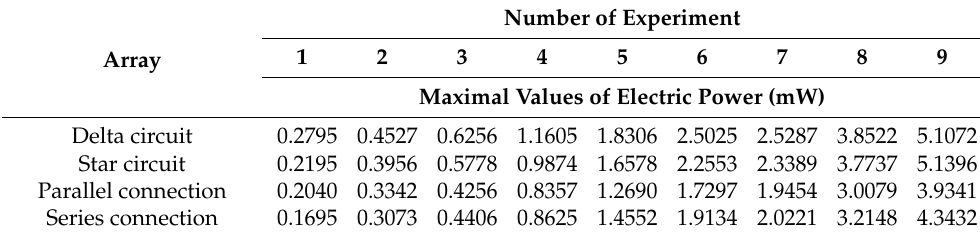
Table 4. Maximal value of generated electric power.